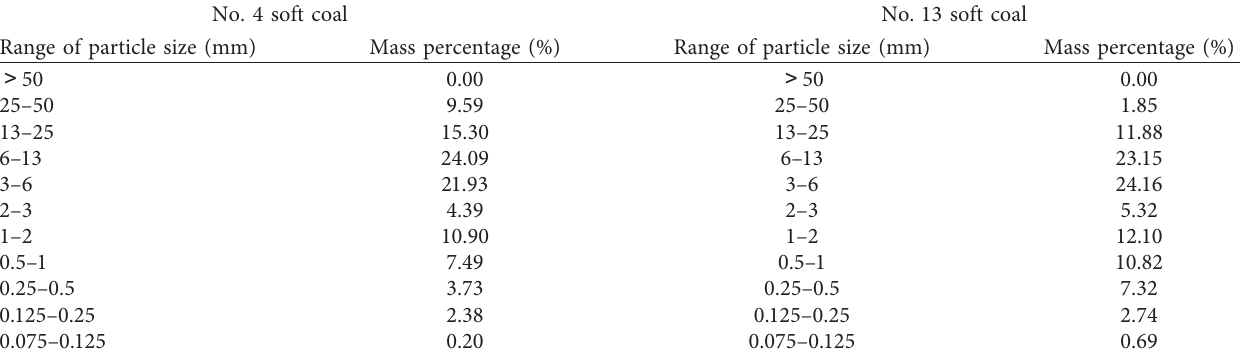
Figure 2: Distribution law of the particle sizes of the hard coal in the different coal seams. (a) Hard coal of the No. 4 coal seam. (b) Hard coal of the No. 13 coal Table 2: Determination of particle size distributions of the soft coal.